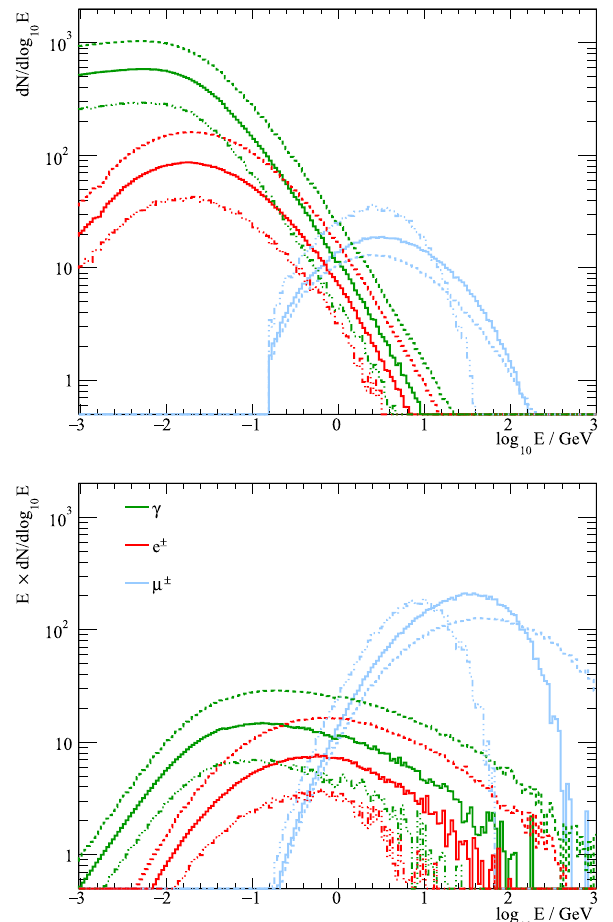
Fig. 2 Number density (top) and energy density distributions (bottom) of ground-level particles at 5 km altitude for vertical showers initiated by primary protons of three energies, solid lines correspond to 1 TeV primary energy, dashed lines to 10 TeV, and dashed-dotted lines to 100 GeV. The distributions of the 10 TeV case have been scaled down by a factor of ten, while the 100 GeV curves have been multiplied by a factor of ten